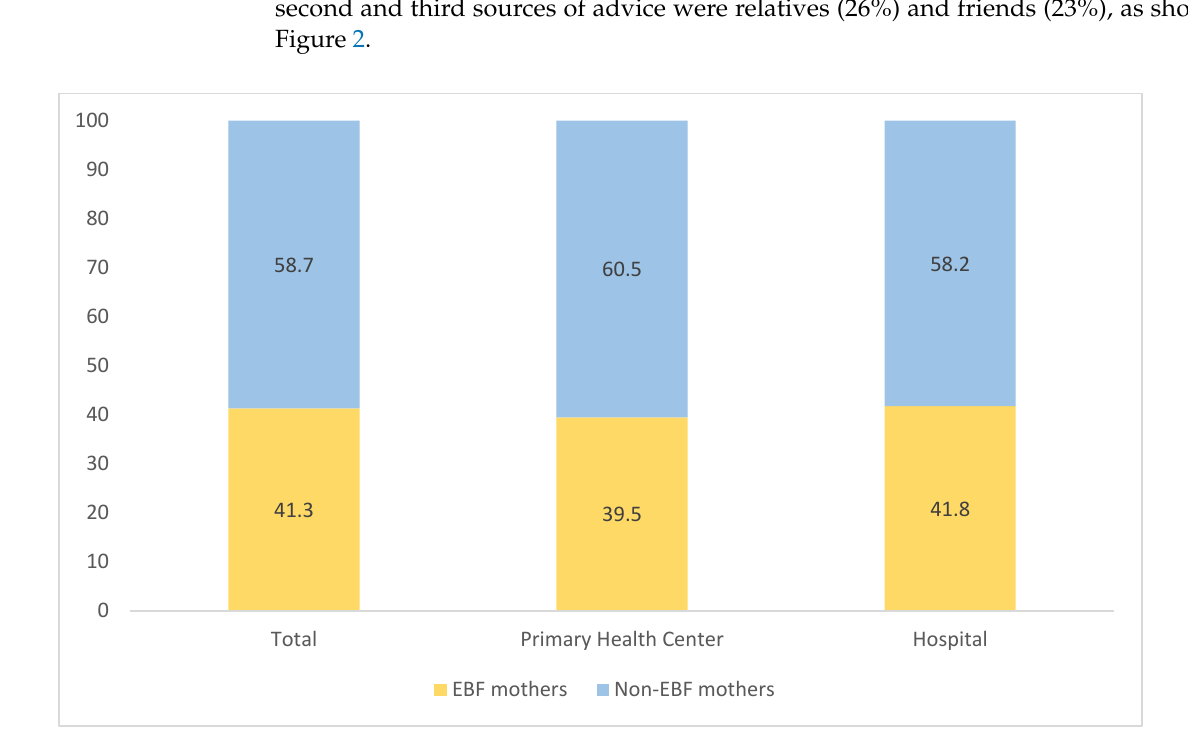
Figure 1. The percentage of participants by types of health facility and EBF outcome. Table 1. Comparing the six-month exclusive breastfeeding (EBF) by personal